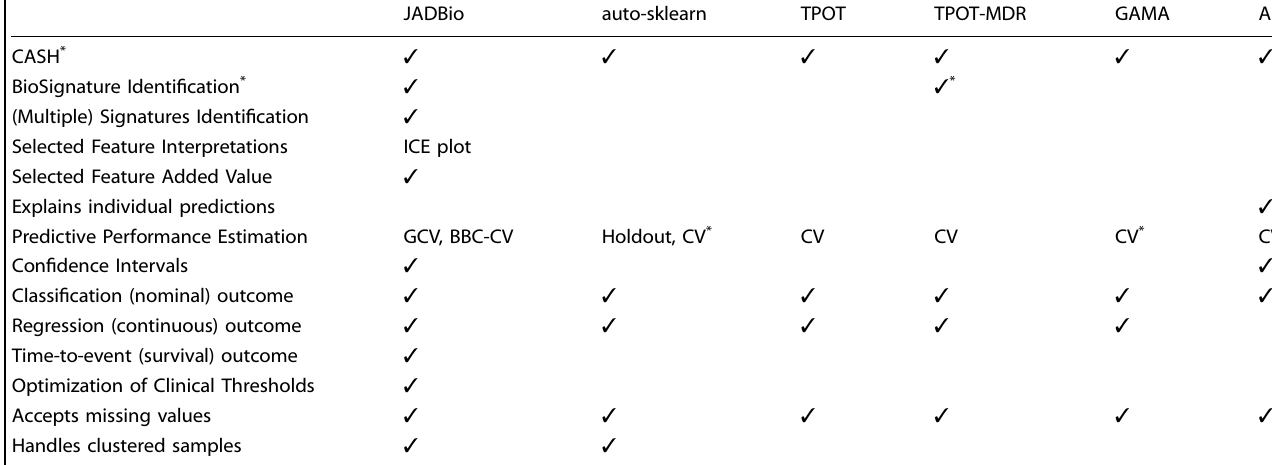
Table 1. AutoML tools functionalities. The presence of a functionality in each tool is marked by a check symbol or by a short name/acronym. Asterisks and short names are explained in the